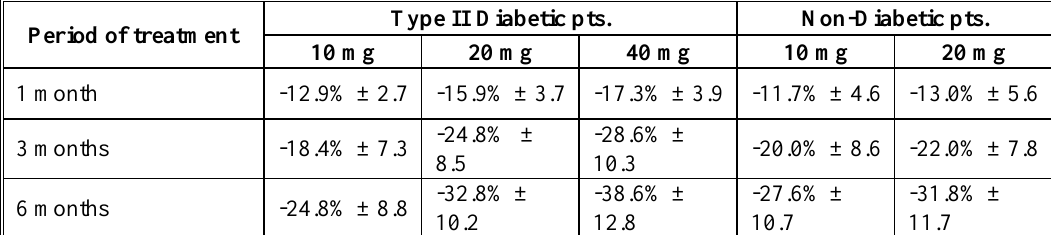
Table 4 :Percentage of serum triglyceride reduction after treatment with Atorvastatin * Type II Diabetic Period of treatment